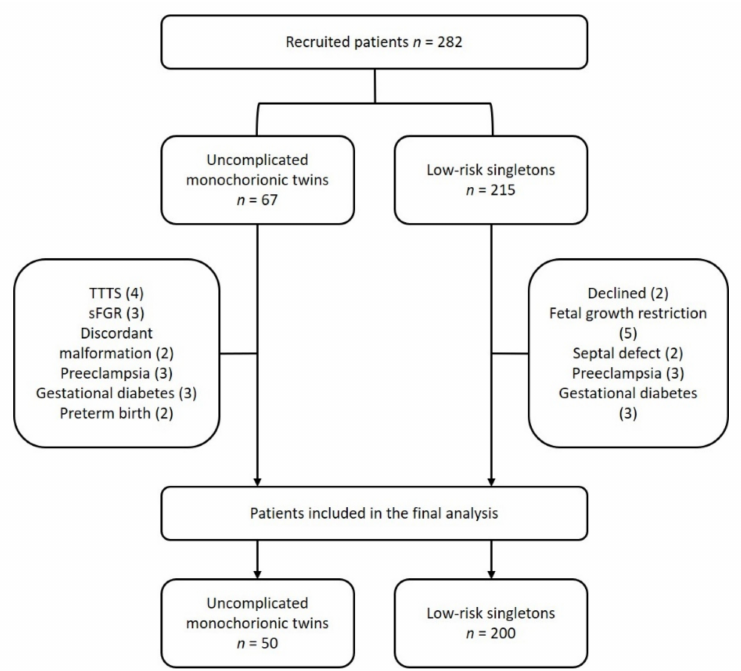
Figure 1. Recruitment flow chart. Fetal echocardiography data were collected from all patients who agreed to participate in the study. Some patients were excluded from further analysis because birthweightandperinataloutcomesmettheexclusioncriteria. TTTS:twin-to-twintransfusionsyndrome, sFGR: selective fetal growth